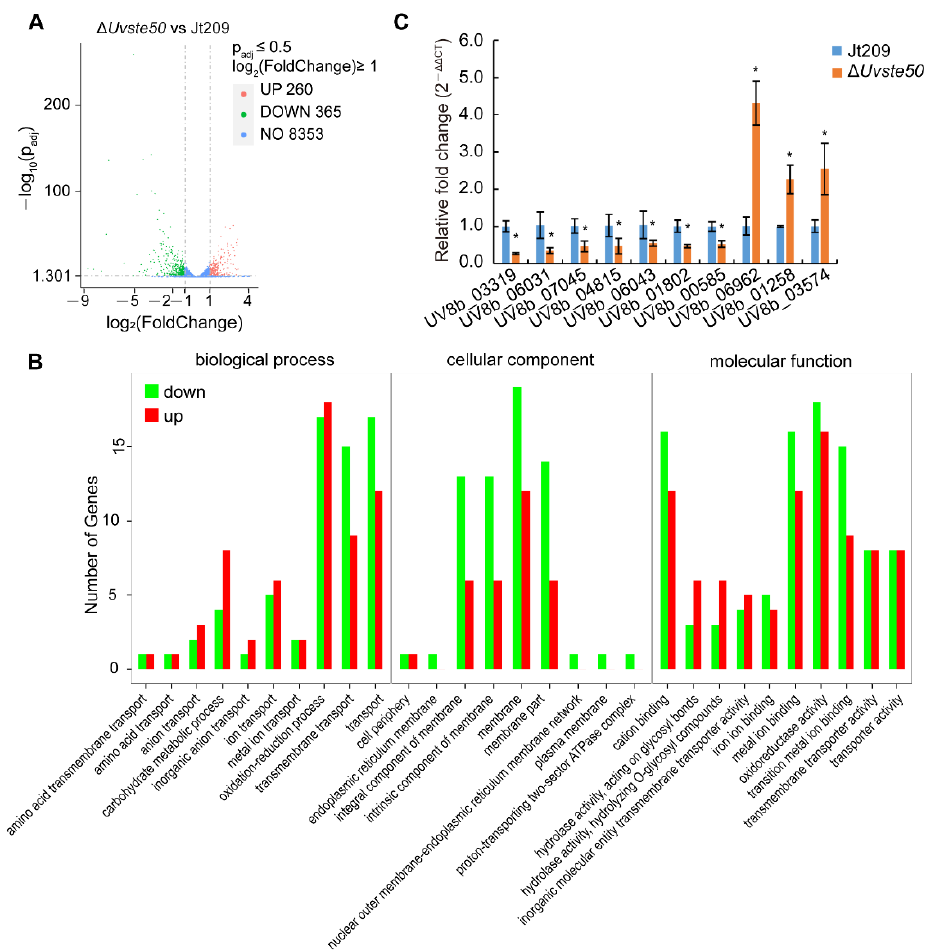
Figure 8. UvSTE50 affects the transcription of a subset of genes in U. virens . ( A ) Volcano map of differentially expressed genes (DEGs). ( B ) Histogram of GO enrichment analysis. ( C ) The expression levels of nine MFS transporter genes and UvCDTF (UV8b_03574) in the Δ Uvste50 mutant. Error bars represent SD. * indicates that the expression level of genes in the ∆ Uvste50 mutant significantly differs from that in the wild-type strain Jt209, as estimated by Duncan’s new multiple range test ( p <